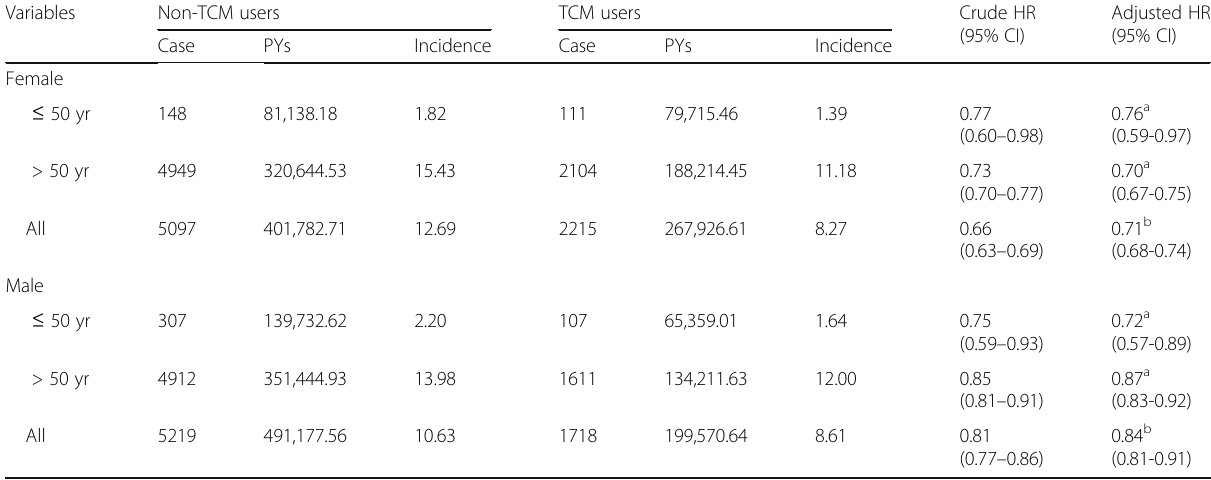
Table 3 Incidence and dementia risk for HTN patients with and without TCM in the stratification of sex and age